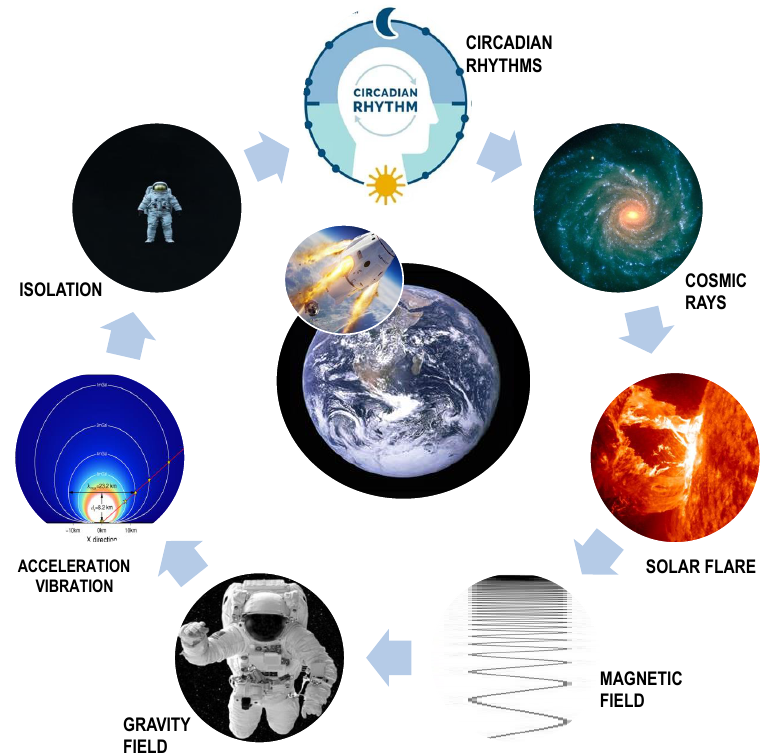
Figure 1. The space environment. Space is a hostile milieu due to dramatic changes in some criti- cal, physical factors that can either directly or indirectly influence living functions. Consequently, people flying in space are exposed to significant changes in the gravitational and magnetic fields while being challenged by galactic cosmic rays and electromagnetic radiation as well as by uncom- fortable conditions characterized by sudden acceleration modifications (comprising deceleration and vibration), physical and psychological confinement, and ultimately, severe disruption of basic chrono-biological